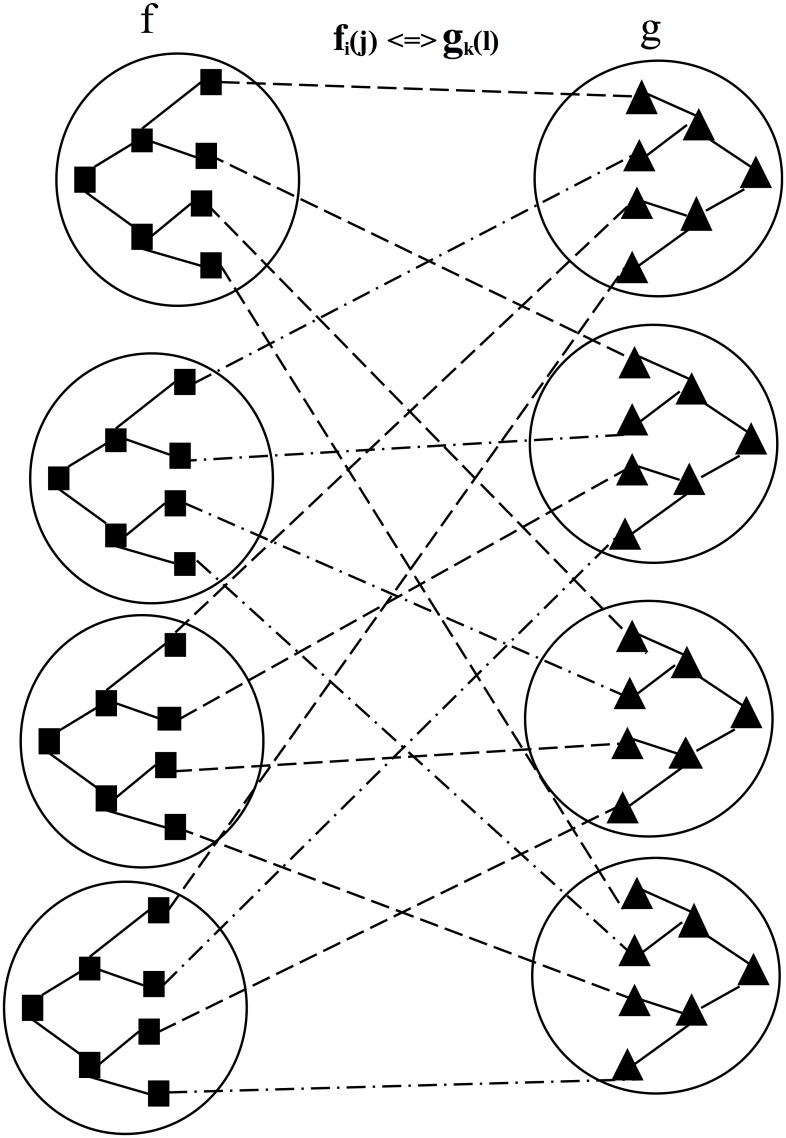
Large-scale semantic linkage analysis of knowledge granules in between the KSCs.